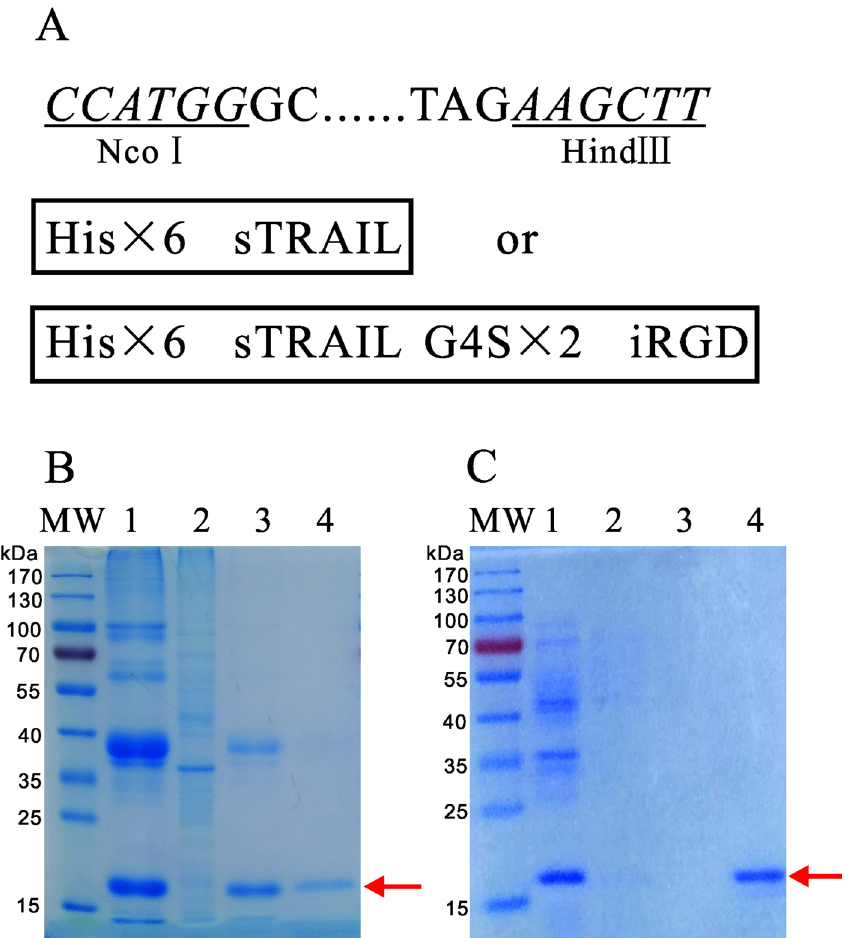
Figure 1. Construction of sTRAIL-iRGD. Restriction sites are underlined; His × 6 and G4S tags are shown in boxes. ( A ) sTRAIL purified via nickel-affinity chromatography (red arrows in the upper panel). ( B ) Lanes 1–3: sTRAIL at 10%, 30% and 50% eluent times; Lane 4: sTRAIL fusion protein expression was validated by SDS- PAGE (red arrows) at 100% eluent times. sTRAIL purified via nickel-affinity chromatography (red arrows in the upper panel) ( C ). Lanes 1–3: sTRAIL-iRGD at 10%, 30% and 50% eluent times; Lane 4: sTRAIL-iRGD fusion protein expression was validated by SDS-PAGE (red arrows) at 100% eluent